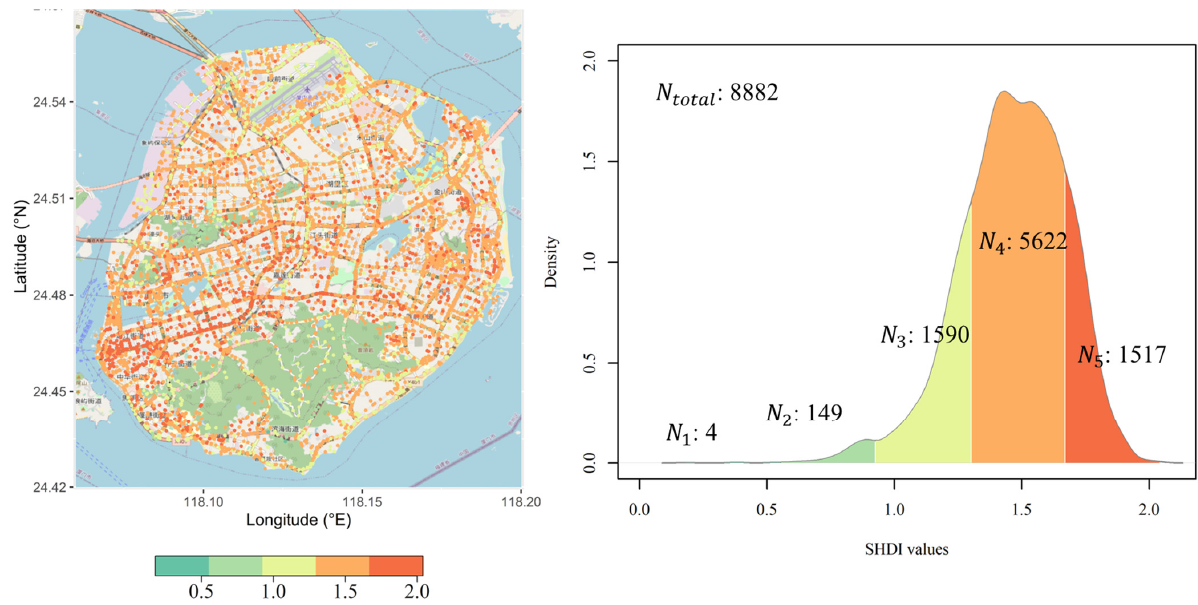
Figure 10. The landscape diversity estimated by the SHDI. The ( left ) is the spatial distribution and ( right ) is its ( right ) is its density.